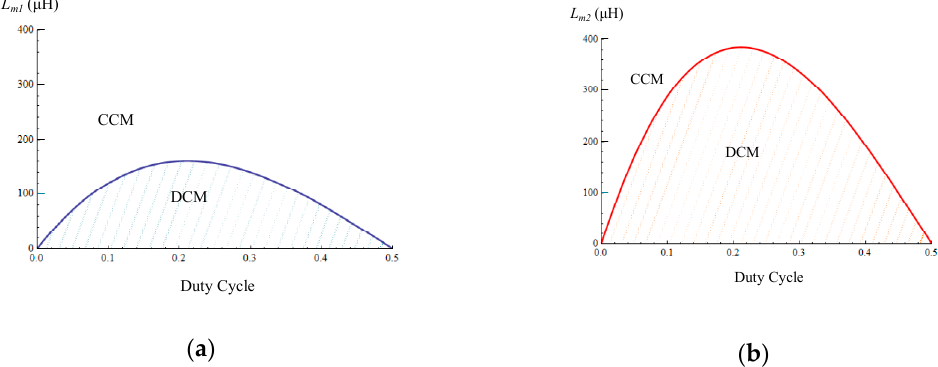
Figure 10. The relationship between the magnetizing inductance and the duty cycle. ( a ) L m 1 , ( b ) L m 2 .